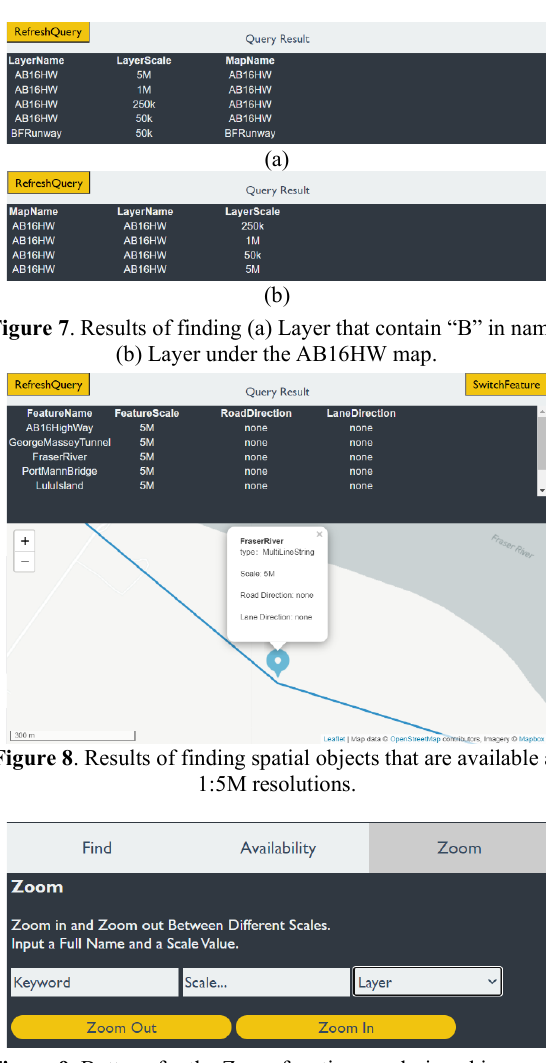
Figure 9 . Buttons for the Zoom function are designed in a more straightforward